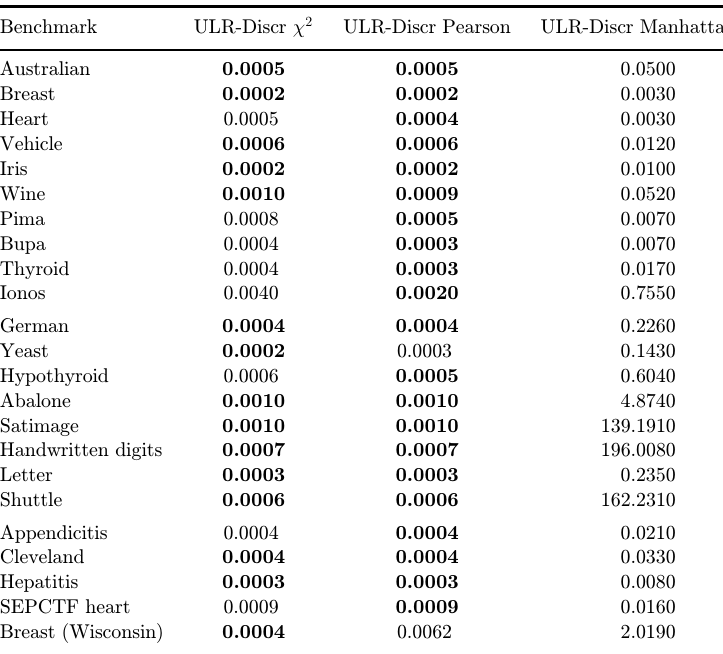
Table 7. Runtime for ULR-Discr using respectively the (cid:1) 2 , the Pearson coe±cient and the distance of